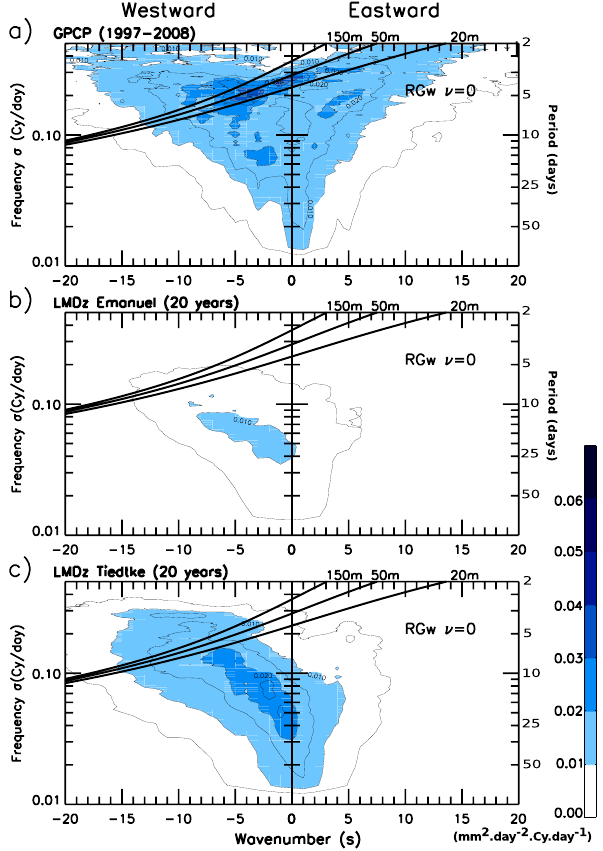
Fig. 3. Same as Fig. 2 except for the antisymmetric component of precipitation. The dispersion curves are calculated for the RGWs ( ν =